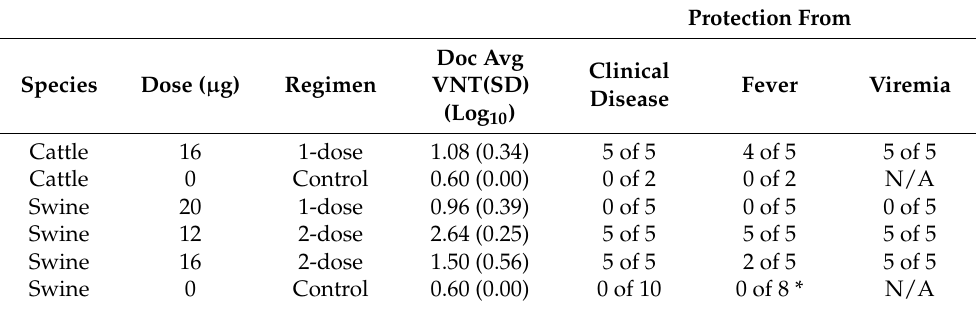
Table 1. Vaccination parameters and clinical results for cattle and swine. Full protection from clinical FMD was achieved with a single mamVLP dose in cattle and two doses of mamVLPs in swine. Protection from fever is defined as rectal temperatures ≤ 39.6 ◦ C, sampled daily, and protection from viremia is defined as negative RT-PCR (Ct < 40) at sampled time points (3, 7, or 8, and 14 days post-challenge for swine and 7, 14, and 21 days post-challenge for cattle). The geometric mean virus neutralization antibody titers (VNTs) with standard deviation (SD) on the day of challenge (doc) are included. Control animals were not sampled for viremia as all animals displayed clinical disease. * Two swine demonstrated clinical FMD lesions before demonstrating fever and were